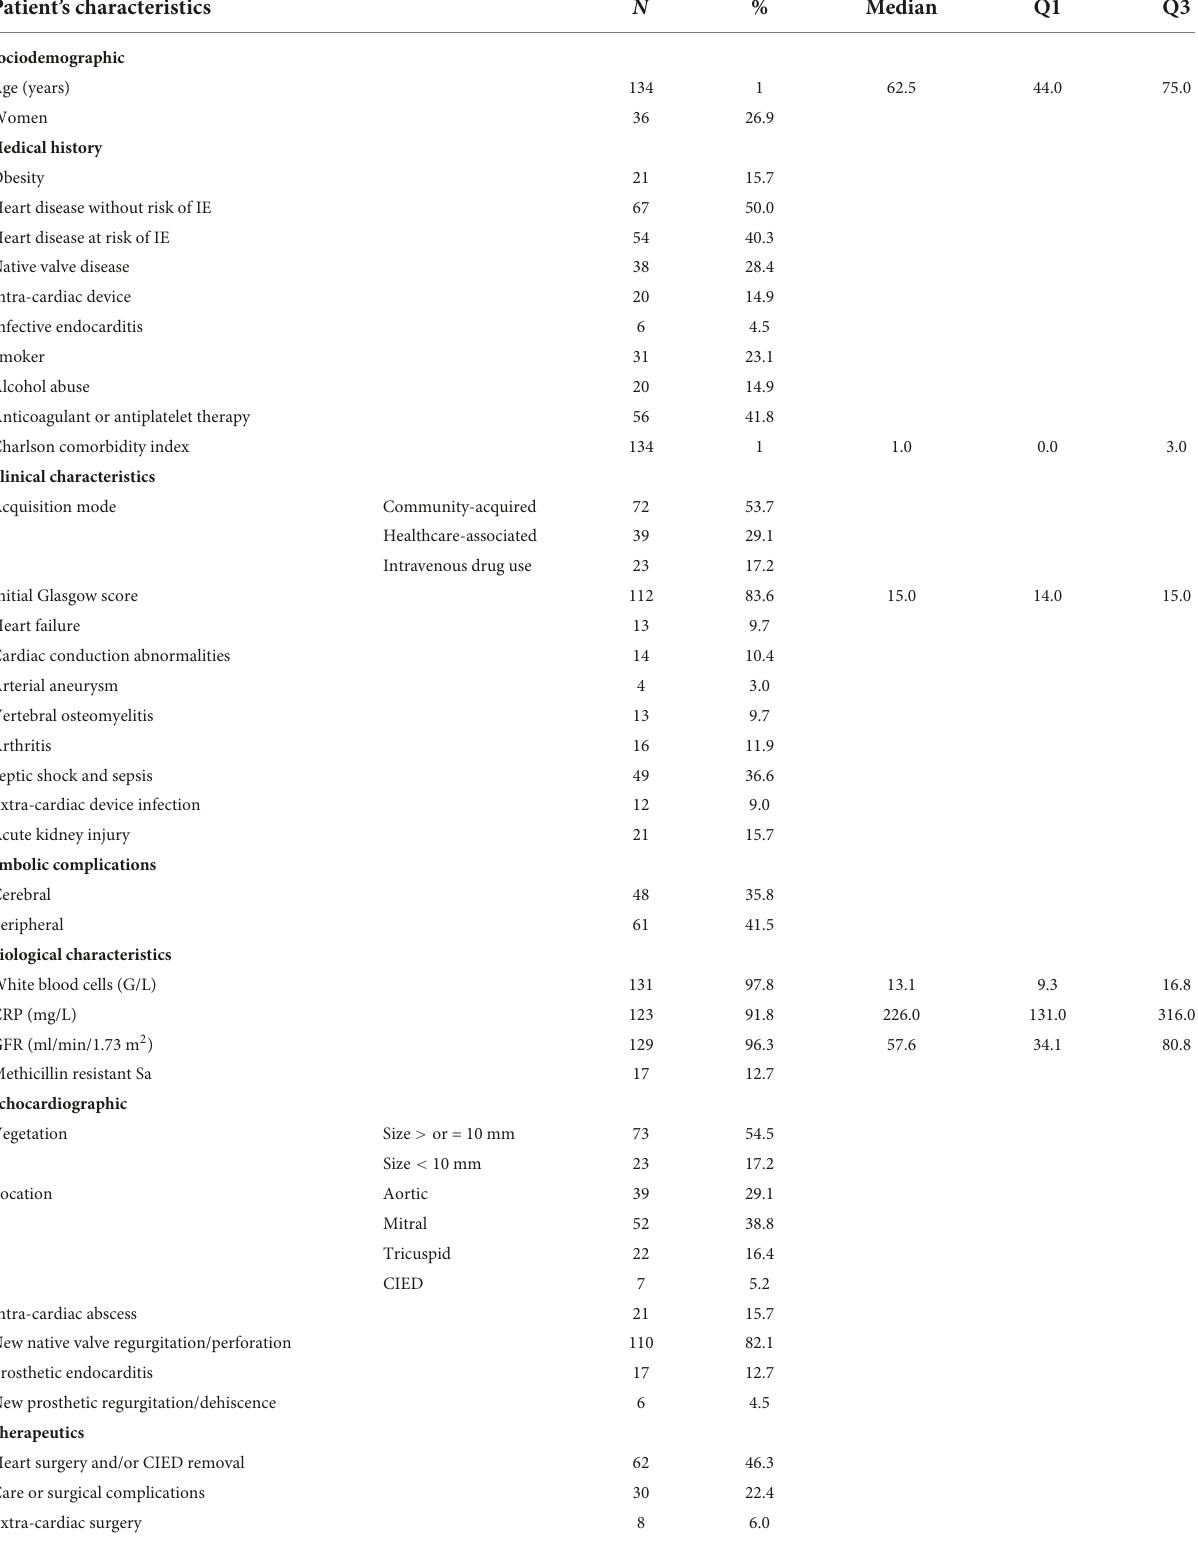
TABLE 1 Main characteristics of the 134 patients with Staphylococcus aureus infective endocarditis. Patient’s